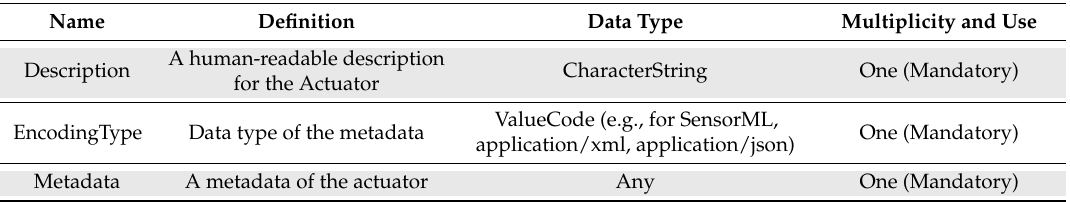
Table 2. Properties of the Actuator